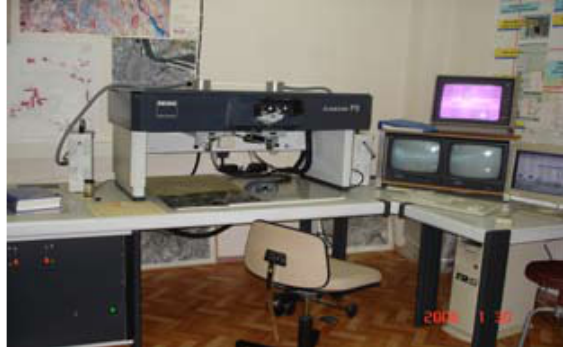
Fig 1. Analytical stereo plotter PLANICOMP P3 with a modification for education